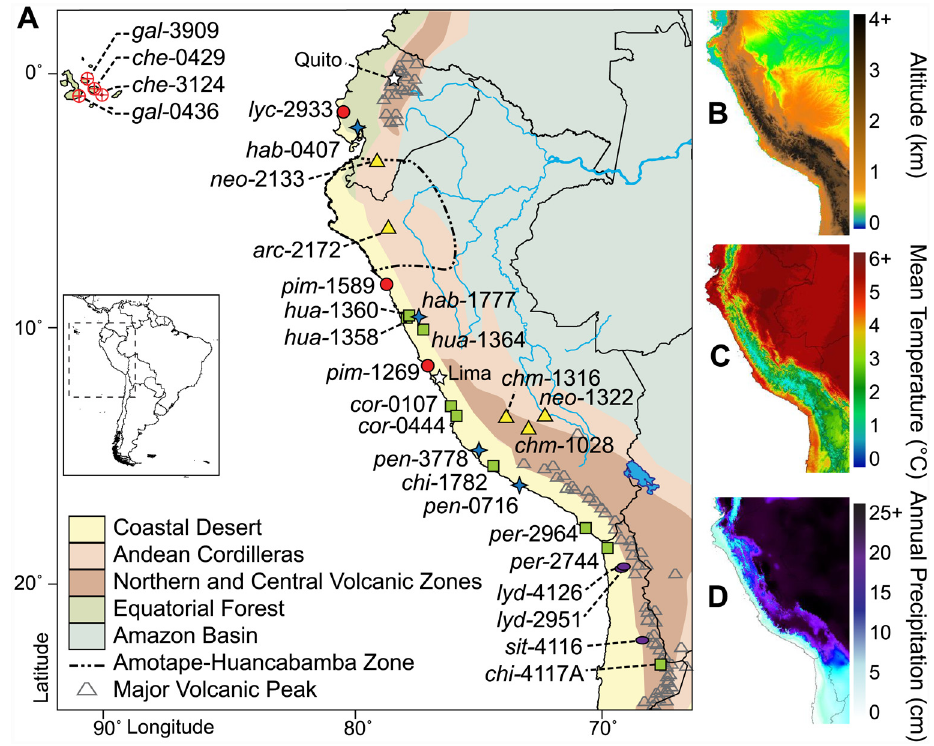
Fig 1. Geographic distribution and ecological diversity of sampled populations of wild tomato. (A) Wild tomato species inhabit diverse ecological zones (shaded regions) along the western coast of South America and the Galápagos Islands. For each sample location, labels indicate species and accession number, and symbols denote major phylogenetic groupings (circle = Esculentum, triangle = Arcanum, square = Peruvianum, star = Hirsutum, oval = outgroup; base map modified from original from http://www. freevectormaps.com). High variation of (B) altitude, (C) mean annual temperature (D), and annual precipitation across the habitat range of wild tomato species (data from http://www.worldclim.org; plotted using GRASS GIS